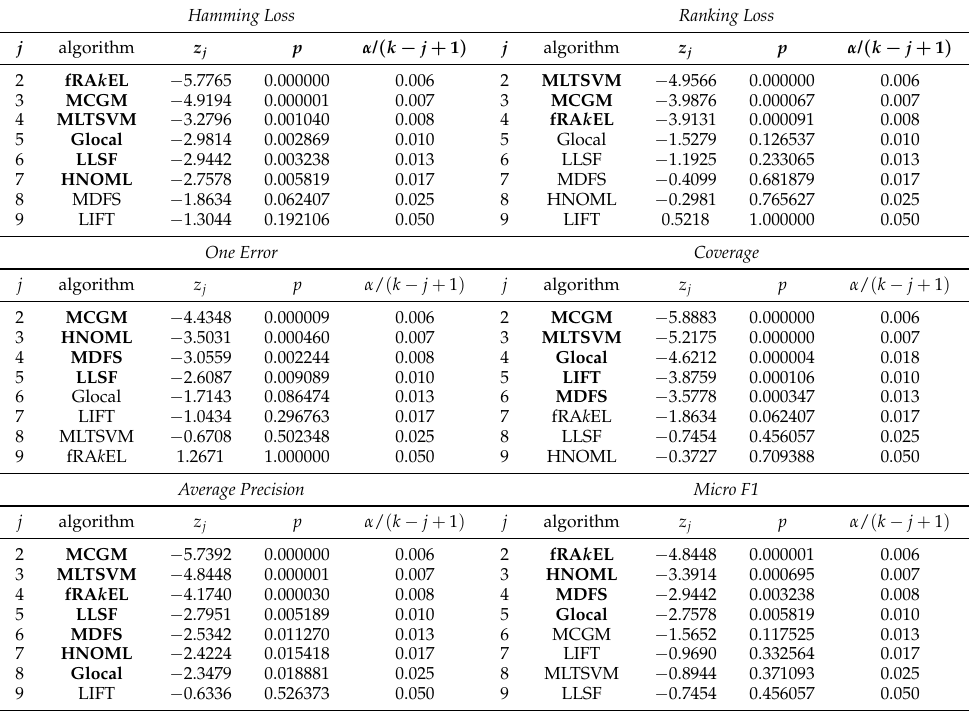
Table 4. Comparison of RGLC (control algorithm) against the remaining approaches. The test statistics z i and p -value are determined by the Holm test at significance level α = 0.05. Algorithms that are statistically inferior than RGLC are in bold